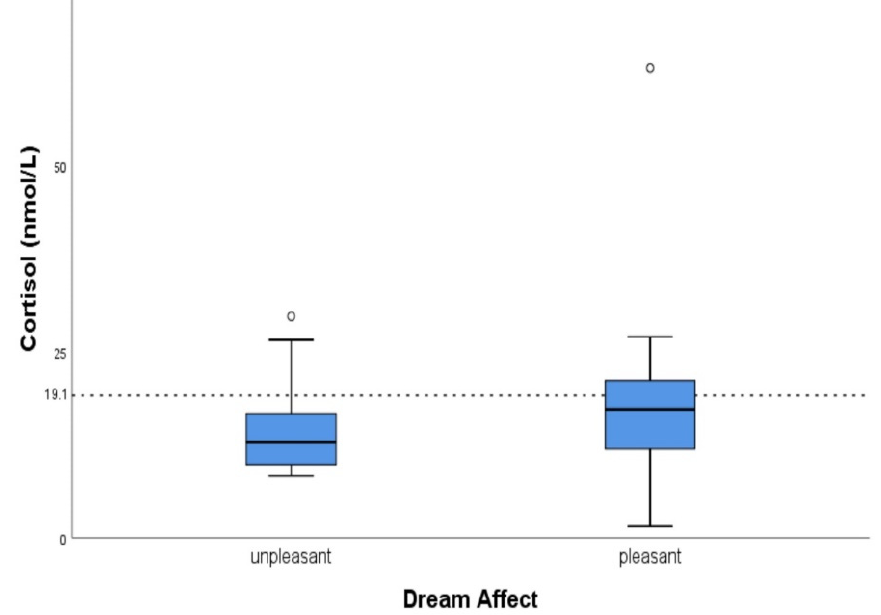
Figure 2. Box plot presenting the association of cortisol levels, after awakening, with dream affect. Horizontal lines represent the median cortisol values for each group. Hollow circles represent the outlier values.